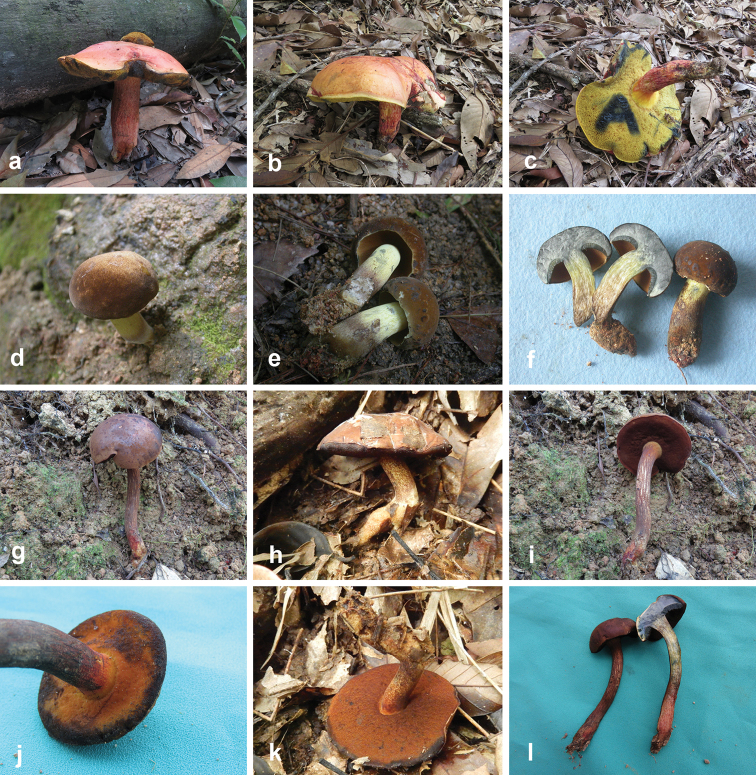

Basidiomata of boletes. a–cLanmaoamacrocarpa (a from FHMU 2212; b–c from FHMU 1982, holotype) d–fNeoboletushainanensis (HKAS 90209) g–lNeoboletusmultipunctatus (g, i–j, l from FHMU 2808 h, k from FHMU 1620, holotype). Photos by N.K. Zeng.